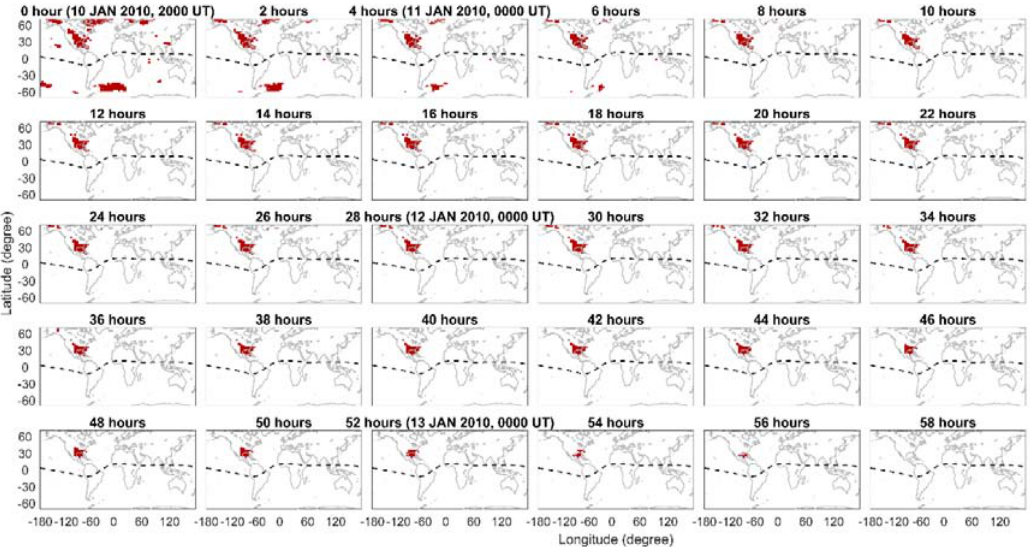
Figure 2. The positive TEC anomaly persists over the Gulf of Mexico (near 25° N, 90° W) for more than two days.